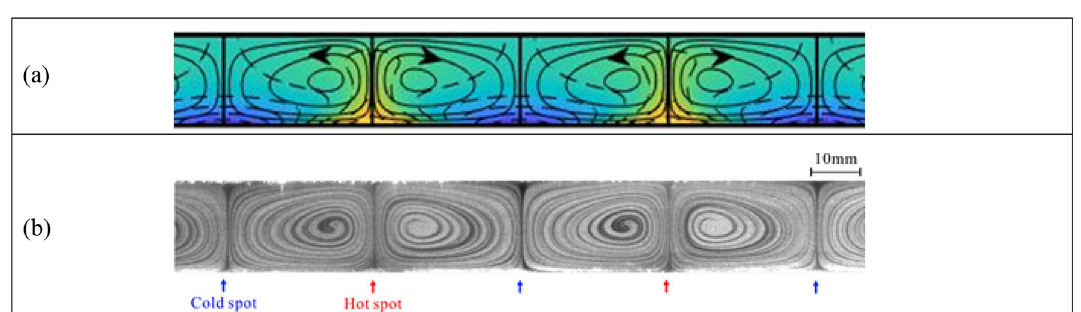
Figure 2. Convection in a slot formed by smooth plates, with spatial modulations entering the system in the form of periodic heating applied at the lower plate while the upper plate is kept isothermal for the periodic Rayleigh number Ra p = 1500 and the heating wave number α = 1 . Further details are provided in the “Methodology” section. ( a ) Theory (colors illustrate the temperature field with equally spaced isotherms; blue— the lowest temperature); ( b ) experiment (different levels of grey result from smoke visualization; Supplementary movie B).